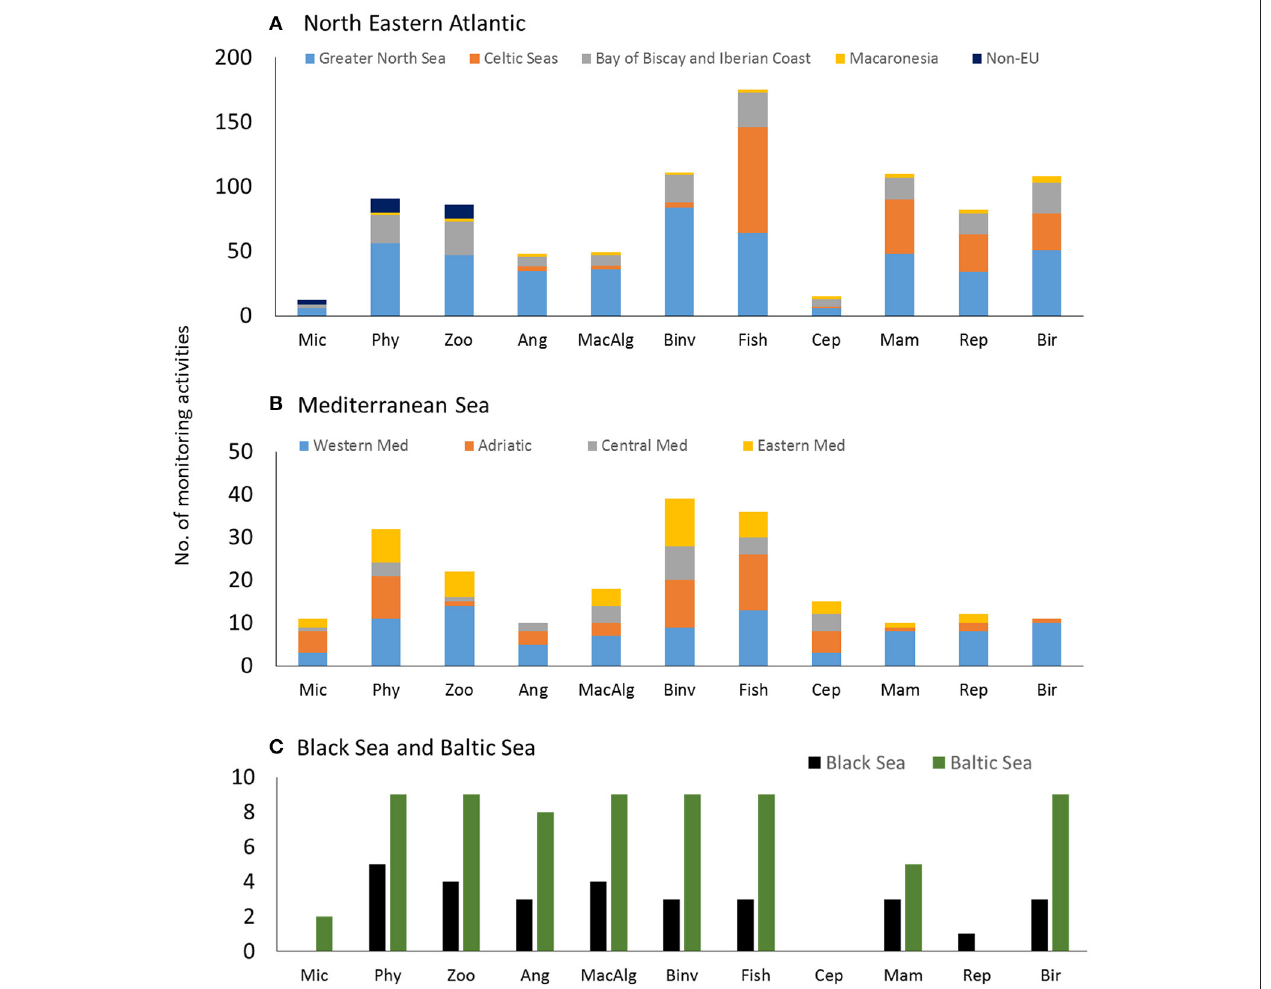
FIGURE 5 | Number of monitoring activities per biological component in (A). The North Eastern Atlantic sub-regions, (B) . Mediterranean Sea sub-regions and (C) . Black Sea and Baltic Sea. Mic, microbes; Phy, phytoplankton; Zoo, zooplankton; Ang, angiosperms; MacAlg, macroalgae; Binv, benthic invertebrates; Cep, cephalopods; Mam, marine mammals; Rep, marine reptiles; Bir, marine birds; Western Med, Western Mediterranean; Central Med, Central Mediterranean including the Ionian Sea; Eastern Med, Eastern